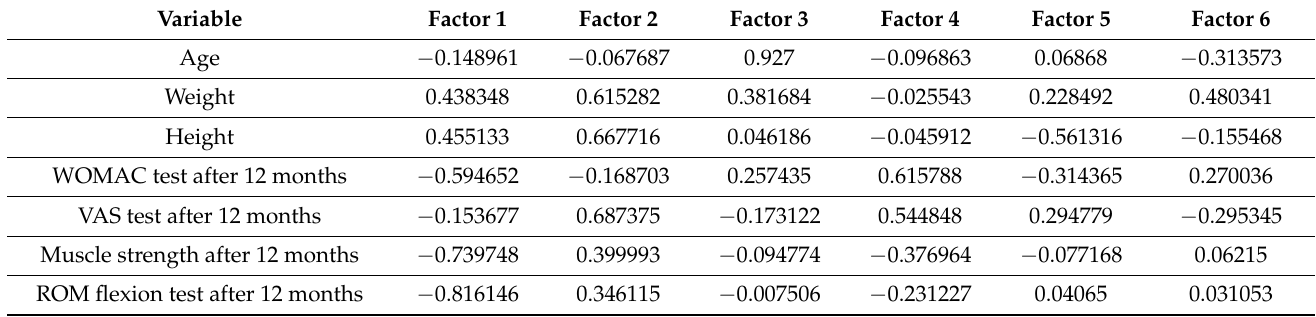
Table 17. Baseline characteristics of the t -test results and factor coordinates of the variables based on correlations with the control group (CG) after 12 months.